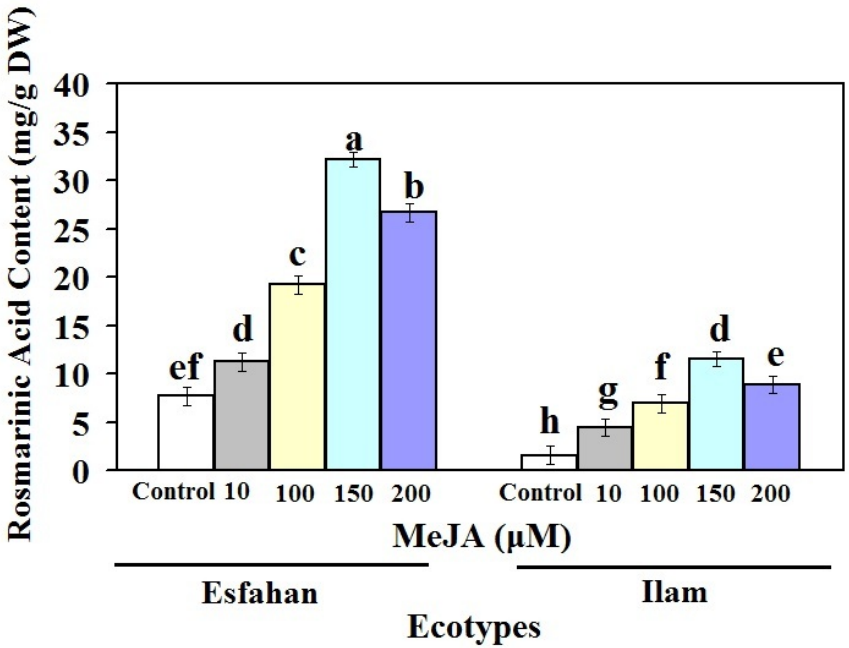
Figure 2. Rosmarinic acid content of leaves of Iranian lemon balm ecotypes treated with different treatments of MeJA. Bars with different letters mean significant at 1% level of probability according to Duncan’s test.